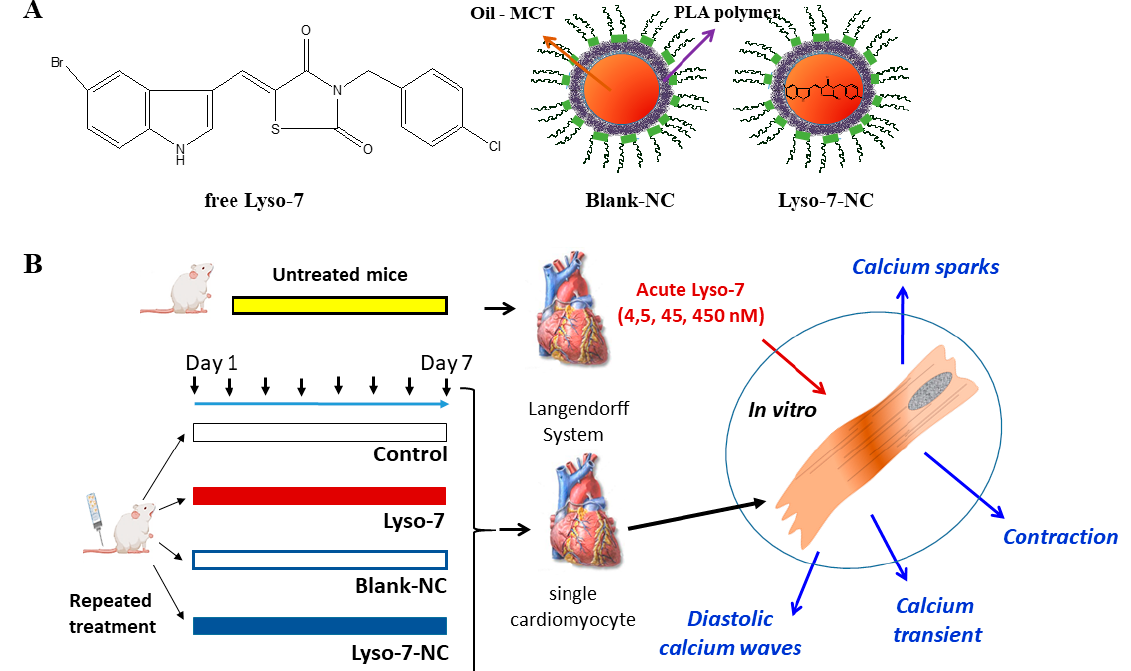
Figure 1. Chemical structure of Lyso-7 and schematic representation of polymeric nanocapsules ( A ). Presentation of the experimental protocol used to treat mice and isolate the cardiomyocytes to test cardiotoxicity of the formulations ( B ) directly in vitro (acute effects) or after in vivo treatment followed by cardiomyocyte isolation.